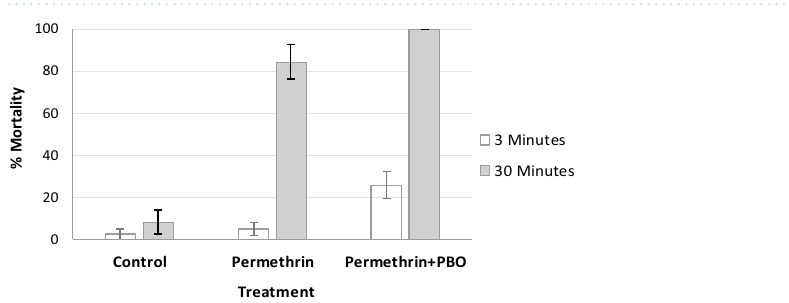
Figure 2. Efficacy of PBO–permethrin blanket in terms of ( a ) KD and ( b ) mortality against susceptible Kisumu and resistant Muleba-Kis strains.